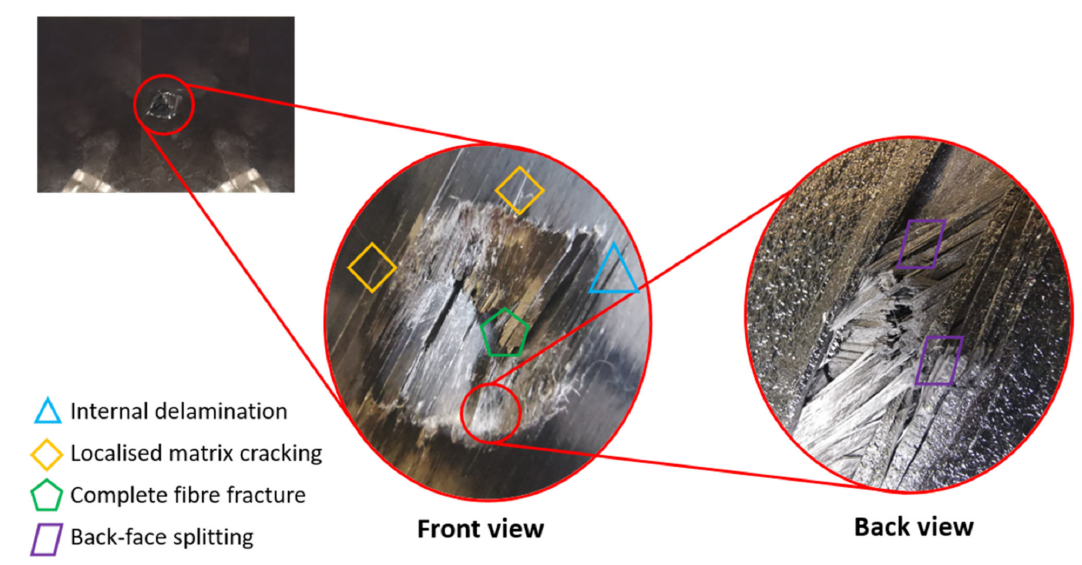
Figure 10. Failure modes of a composite specimen for a 13.75 J impact energy.